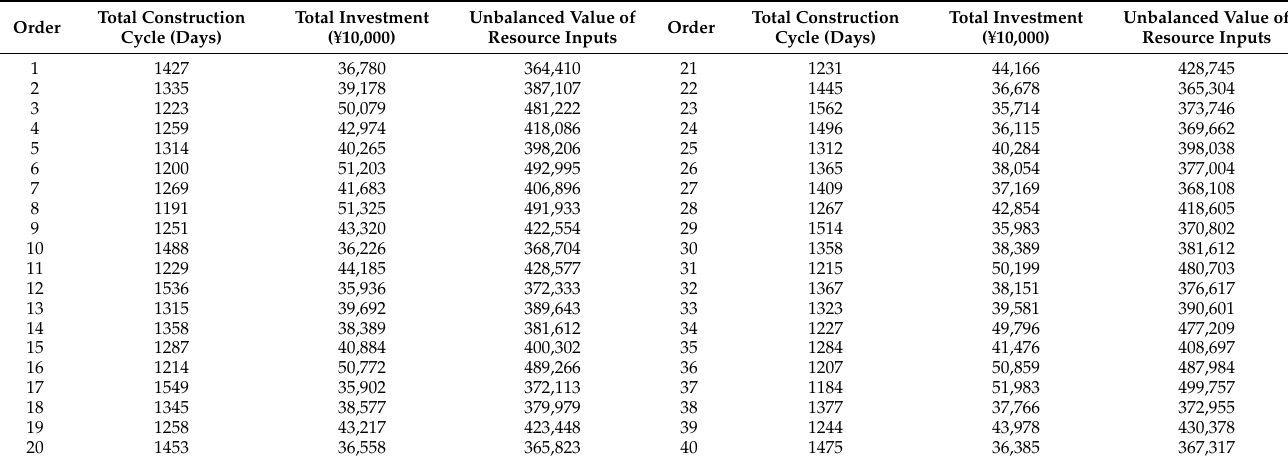
Table 2. Pareto solution set of NSGA-II.